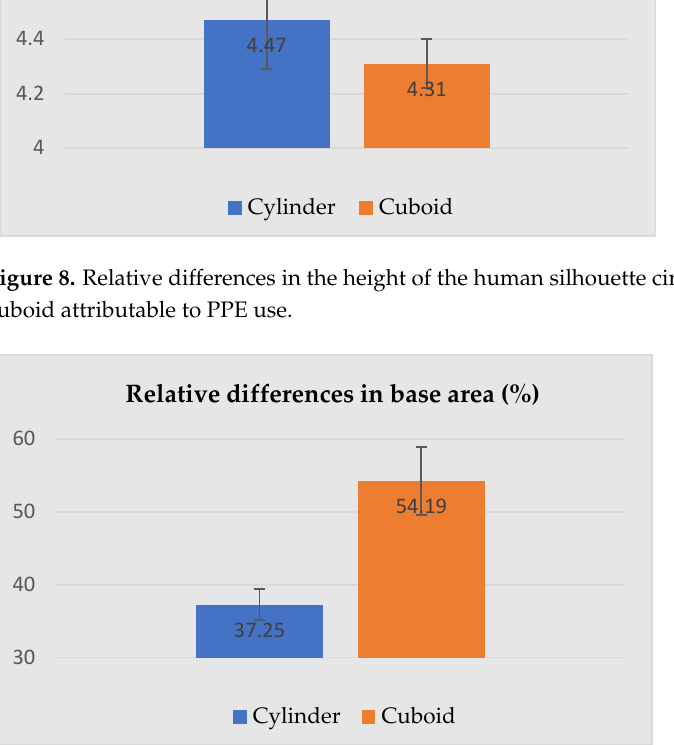
Figure 9. Relative differences in the base area of the human silhouette circumscribed by a cylinder and cuboid attributable to PPE use.